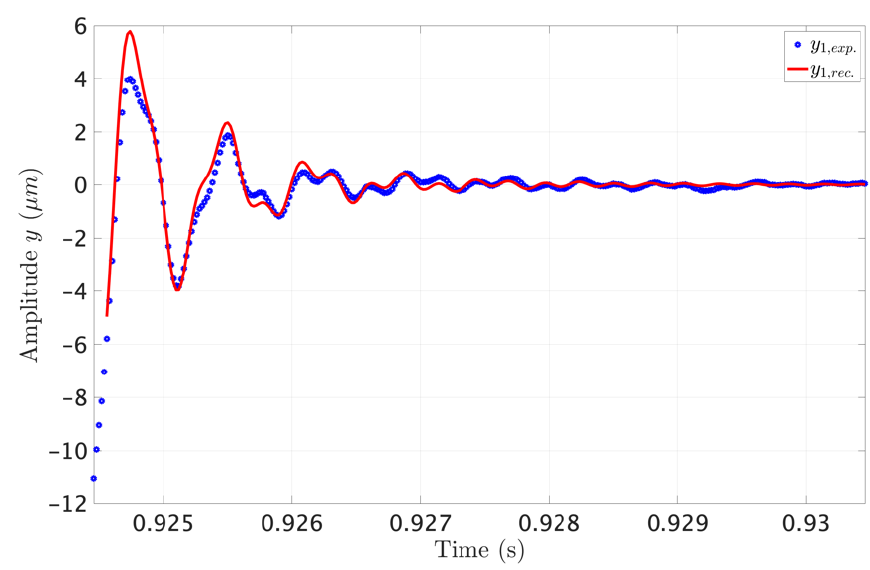
Figure 6. The experimental and reconstructed time signals at 0.5 MPa supply pressure.